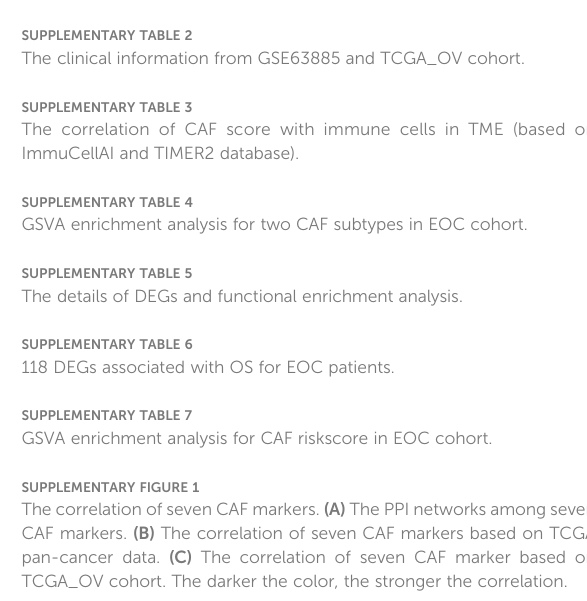
SUPPLEMENTARY TABLE 1 The CAF score for TCGA pan-cancer